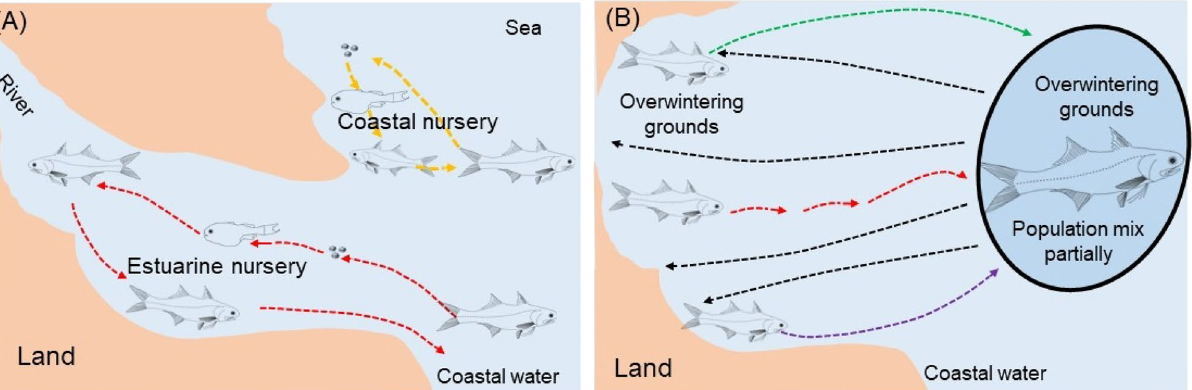
Figure 9. Diversity of early life history and population connectivity. ( A ) Diagrammatic model of life history of estuarine nursery type and coastal nursery type. ( B ) The juvenile subpopulations from different natal nurseries partially mix at the overwintering grounds, and then migrate back to the coastal habitats. The green, red, purple arrows indicate the fish migrating from natal nurseries to overwintering grounds, and the black arrow indicates the part of mixed fish population back to different coastal